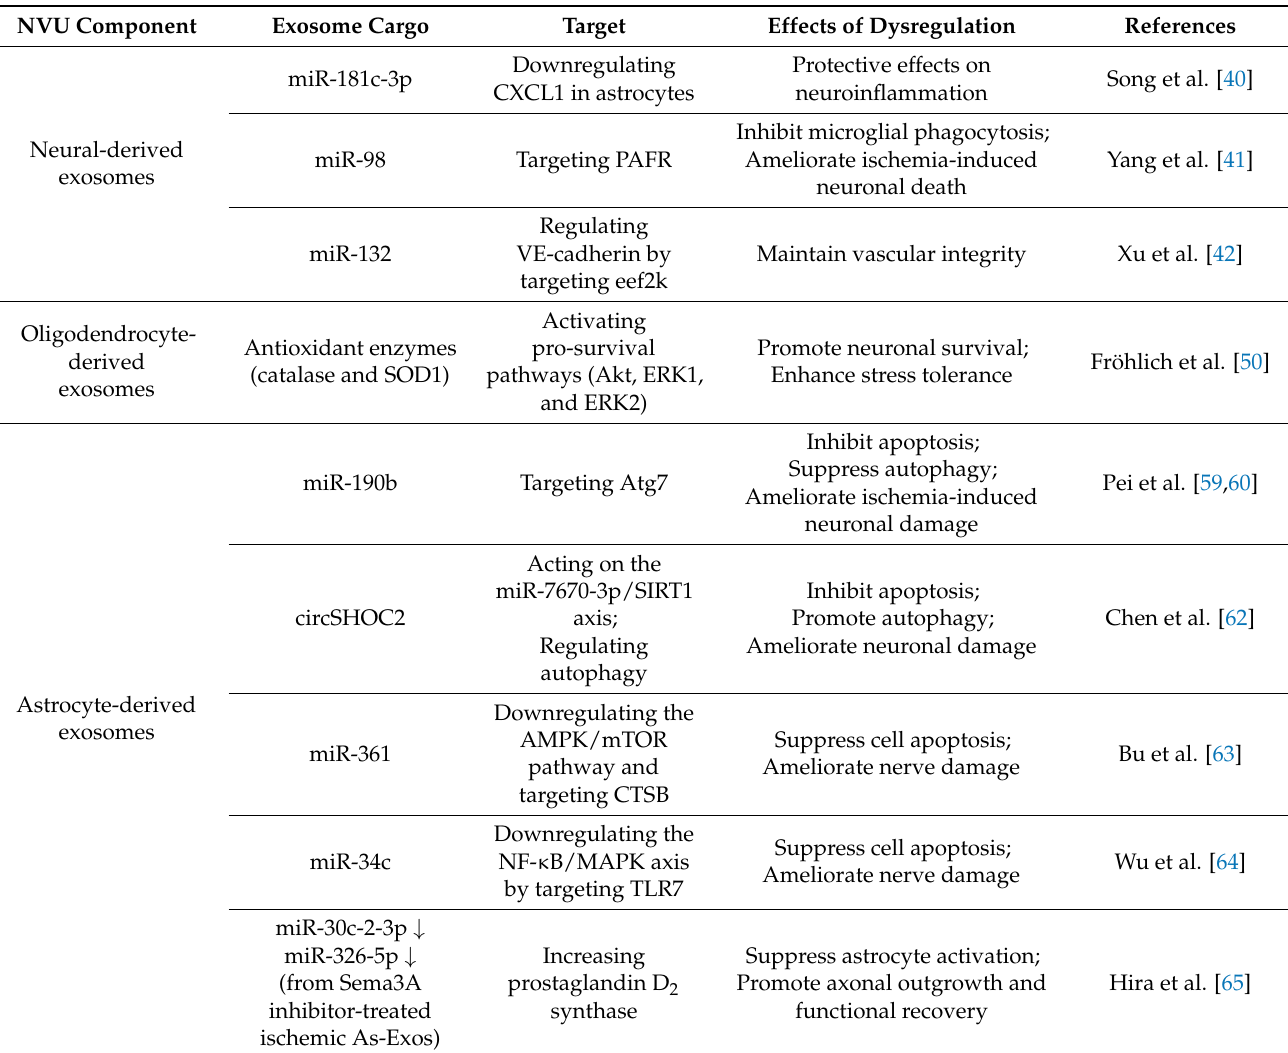
Table 1. Prognostic and diagnostic markers carried within NVU component-derived exosomes. NVU